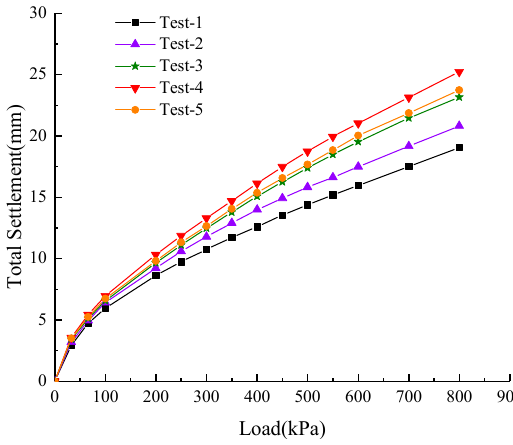
Figure 7. Curve of load–total settlement.